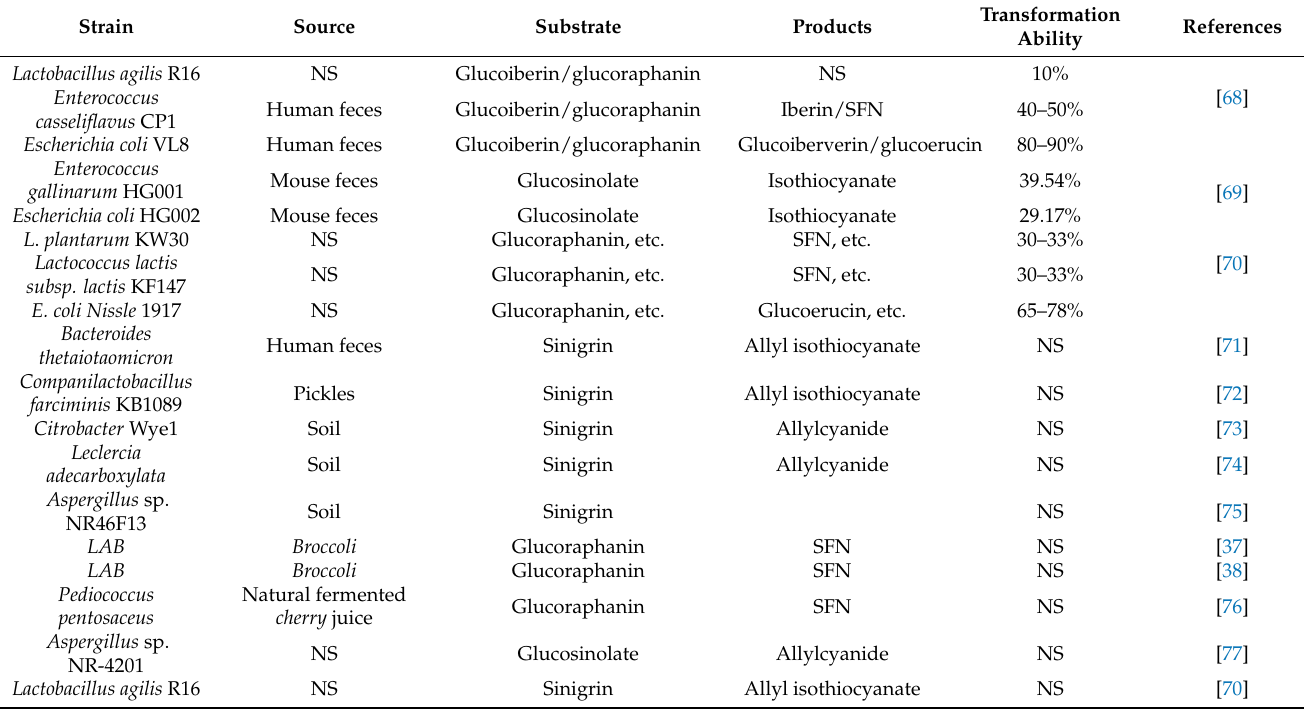
Table 1. Microorganisms with myrosinase synthesis